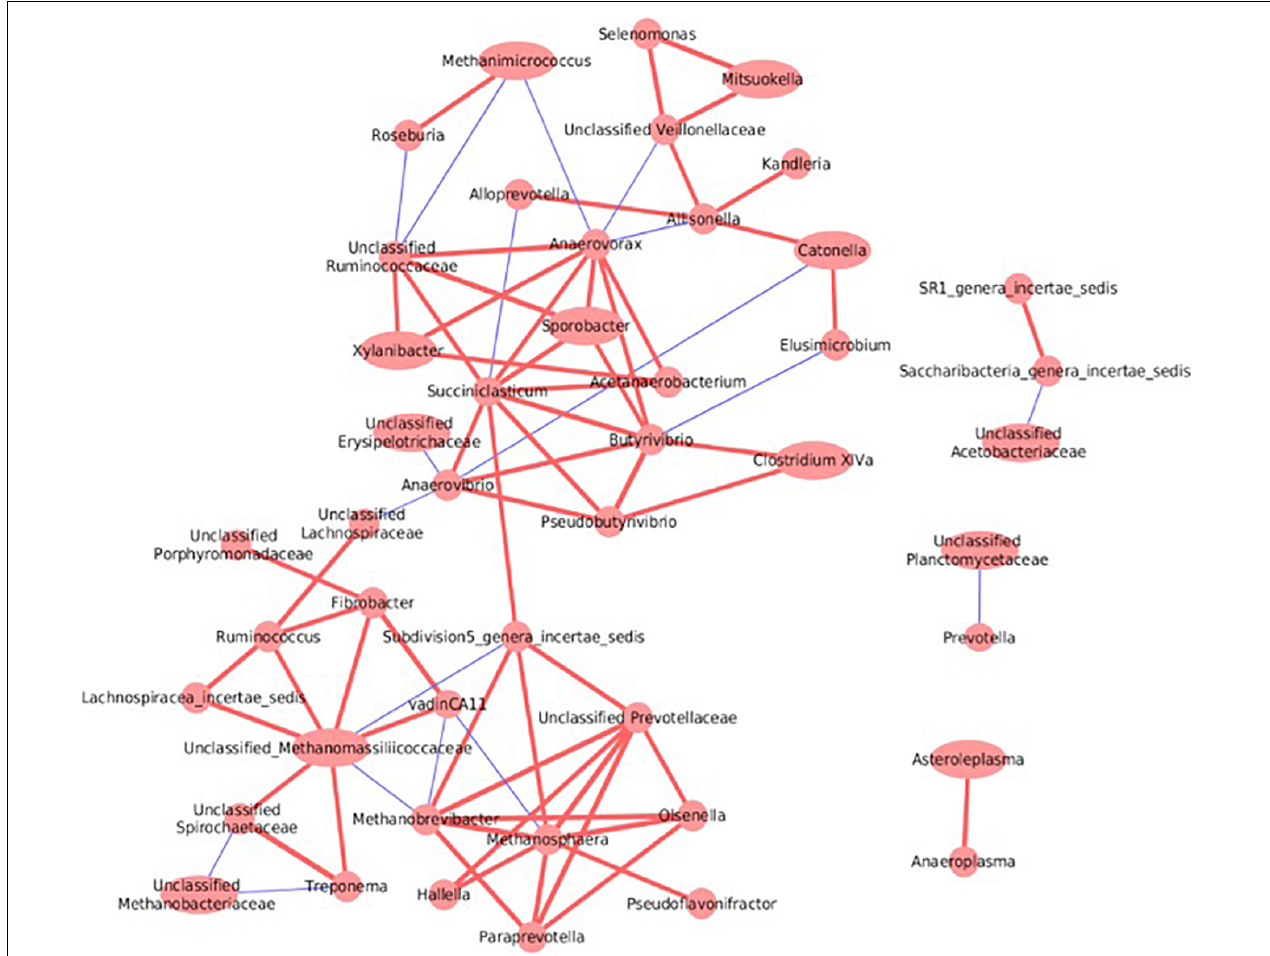
FIGURE 8 | Co-occurrence network analysis between rumen bacterial taxa and archaeal taxa. Only correlations with coefficient > 0.5 or < –0.5 and with P value < 0.05 were displayed. The width of circle corresponds to the relative abundance of individual taxa. Different line colors are used to indicate a positive (red) or negative correlation (blue) between two taxa and the strength of correlation is indicated by the thickness of the